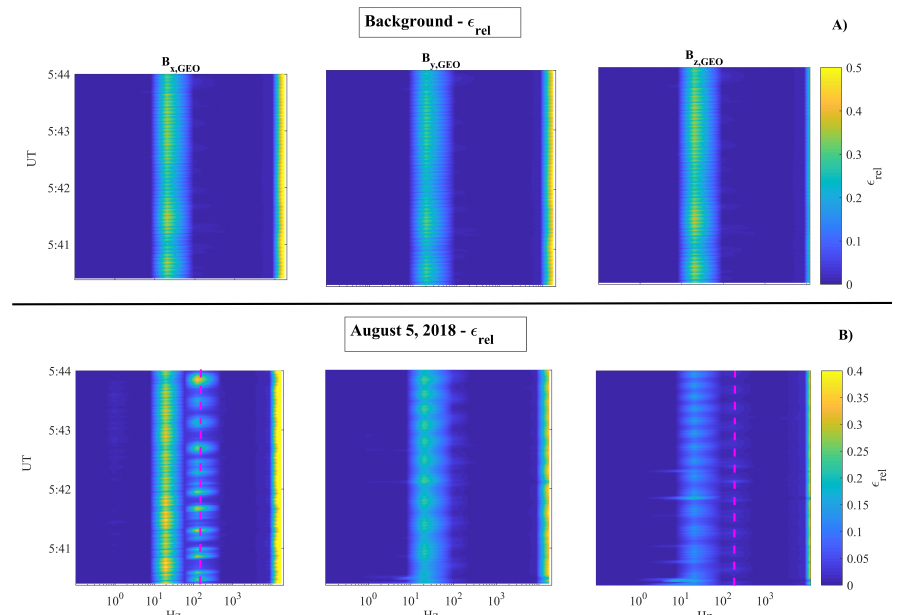
Figure 8. CSES satellite Search Coil Magnetometer observations. Box ( A ) Environmental background evaluated over the earthquake epicenter in terms of ¯ (cid:101) rel vs. time and frequency for the reference quiet condition ( M ≤ 2; Sym-H = [10 nT, − 10 nT]; AE < 100 nT) for the three components of the magnetic field; Box ( B ) (cid:101) rel evaluated over the earthquake epicenter on 5 August 2018 for the three components of the magnetic field. Magenta vertical dashed lines represent anomalous peaks at ∼ 180 Hz. Colors are representative of the (cid:101) rel